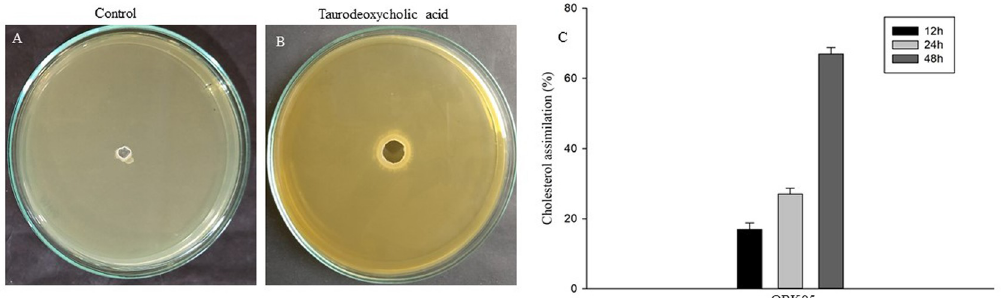
Fig 7. Bile salt hydrolase and cholesterol assimilation potential of the probiotic bacterium P . pentosaceus OBK05. (A) Un- cultured Taurodeoxycholic acid, (B) OBK05 cultured Taurodeoxycholic acid developed precipitation around the well, which indicates BSH activity, (C) Gradual increase in cholesterol reduction at 12, 24 and 48 h of incubation. Experiments were carried out in triplicates, and data with Error bars represent as the Mean ± S.D. values of the independent investigation (p <